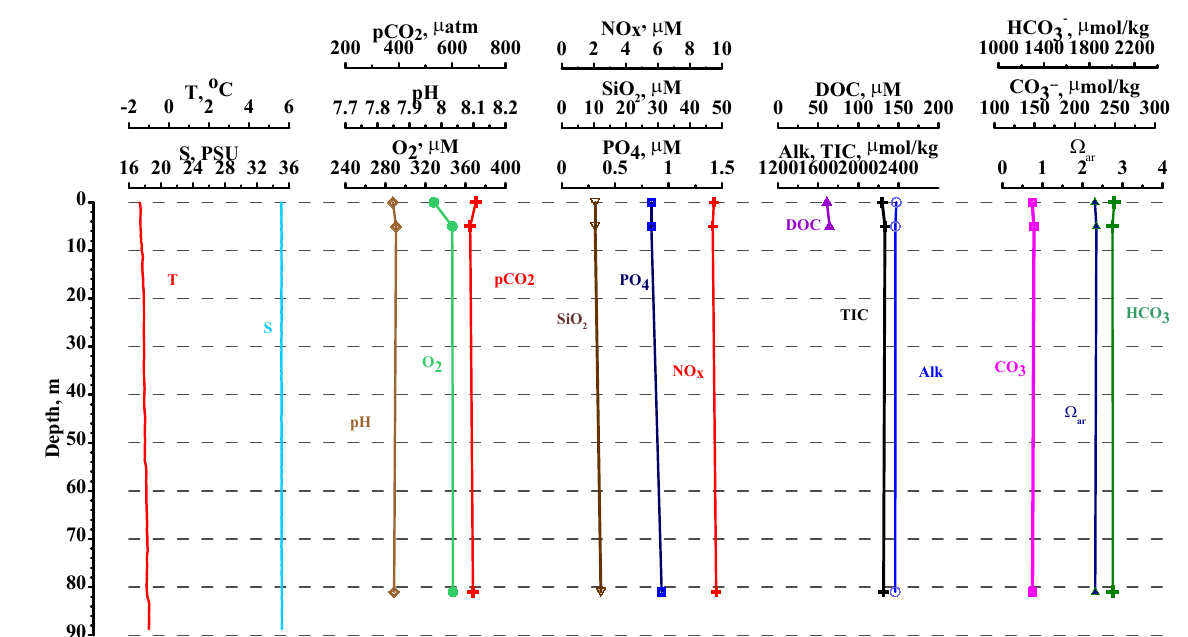
Figure A6. Vertical distribution of physical and chemical parameters at station TM5 (19 March 2014).